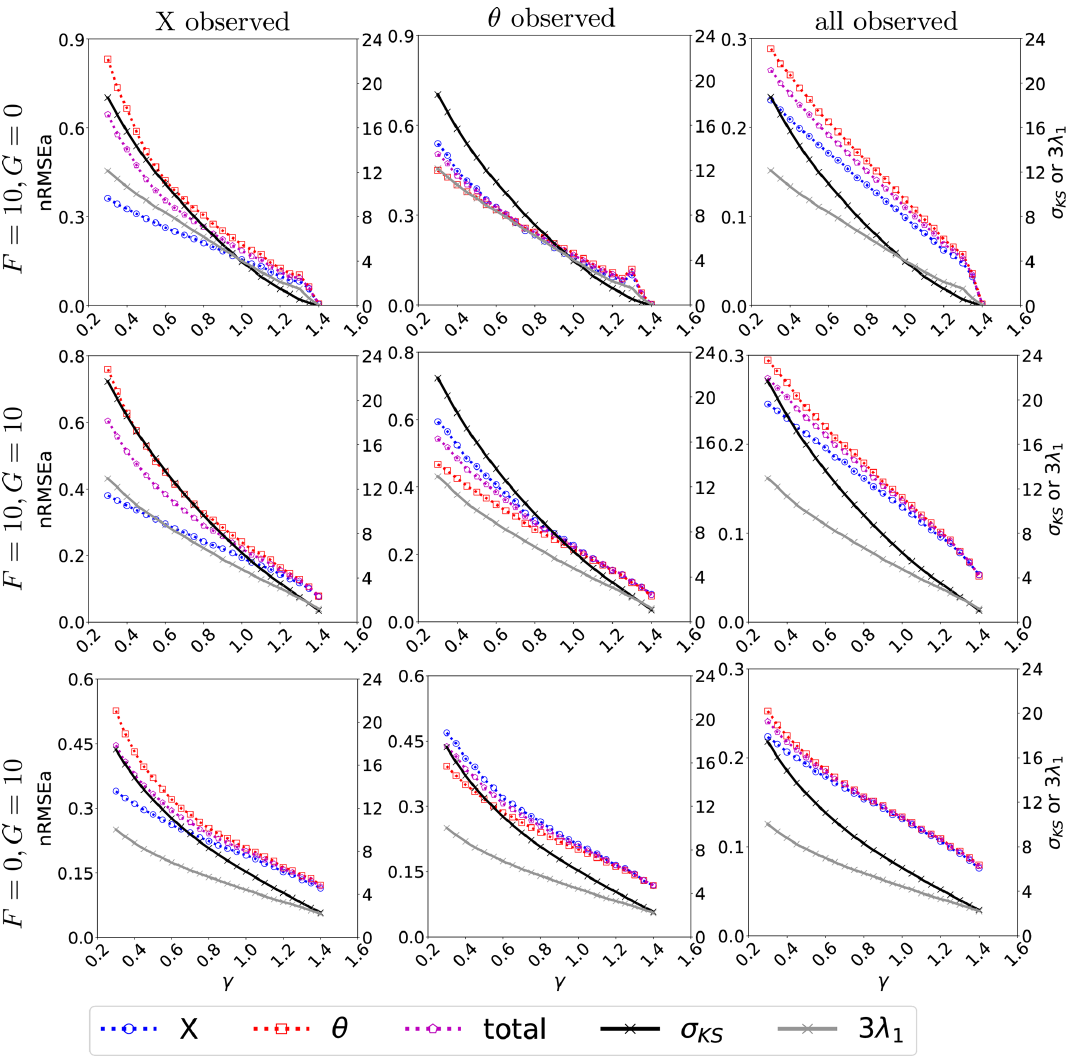
Figure 5. The nRMSEa with varying dissipation coefficients γ ∈ [ 0 . 3 , 1 . 8 ) (with an interval of 0.05) and α = 1. The left axis represents nRMSEa (dashed lines), while the right axis shows the σ KS (solid black line) and the λ 1 (solid grey line) scaled by a factor of 3. The results come from perfect model assumption with observations at each time step where all variables, only X , or only θ is observed. The dashed blue line indicates the nRMSE of the X variable, the dashed red line represents the nRMSE of the θ variable, and the dashed purple line shows the nRMSE of the entire state